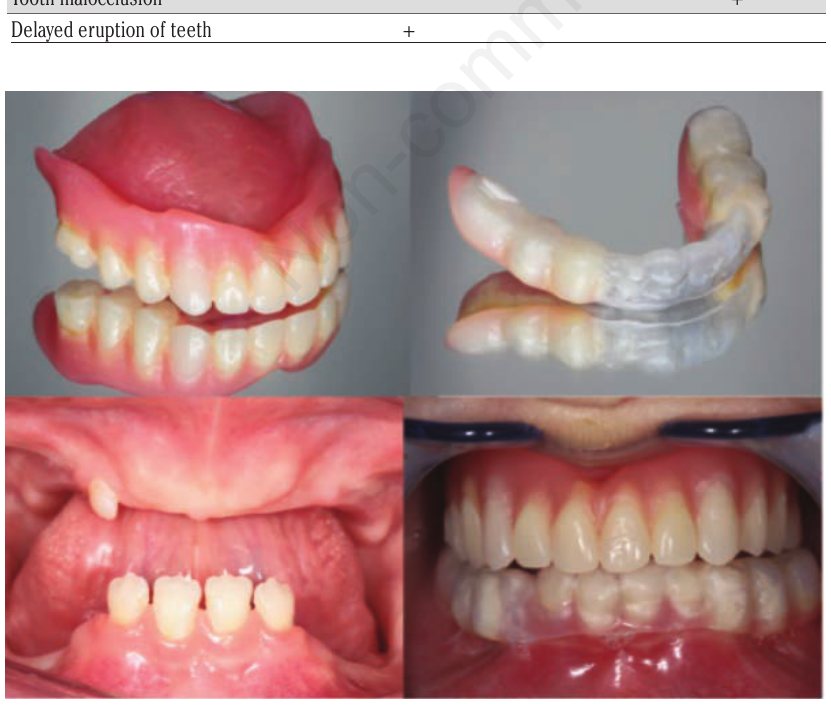
Figure 2. Upper and lower dentures and intra-oral pictures before and after the insertion of the